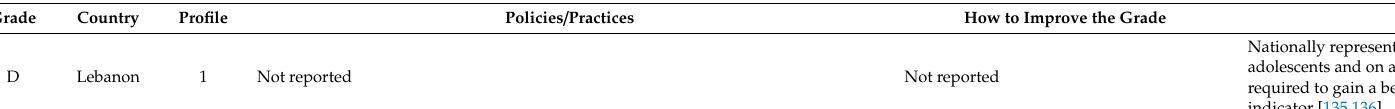
Nationally representative samples for children and adolescents and on all active transportation means are required to gain a better understanding of this indicator